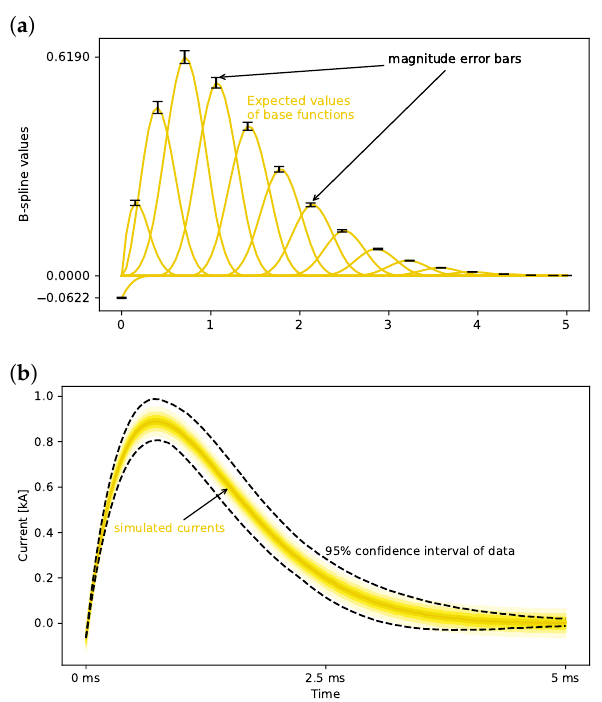
Figure 5. Bayesian model of the current signal manages to capture some of the uncertainty. Plot ( a ) shows, that error bars for splines further from start are much thinner than initially. The ribbon plot ( b ) shows quantiles of simulated output values compared to point quantiles of data. As we can see there is an underestimation of uncertainty in the middle of the signal.